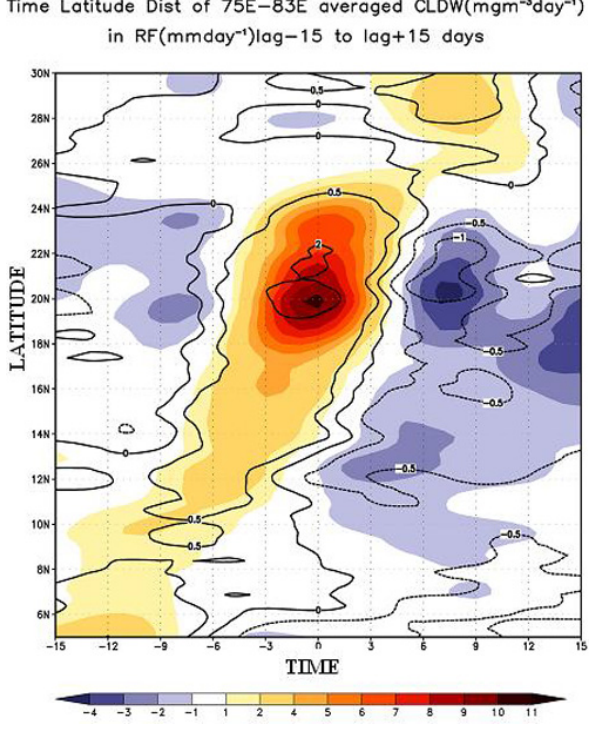
Fig. 11. H¨ovm¨oller diagram of rainfall (mmday − 1 ) (shaded) super- imposed with the cloud water (mgm − 3 day − 1 ) (contour).